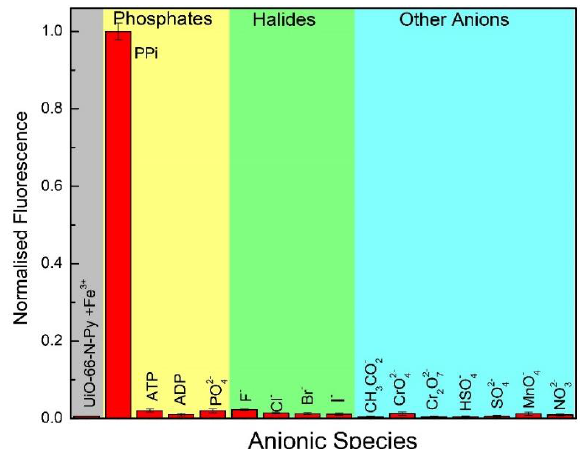
Figure 7. Change in the normalized fluorescence emission of UiO-66-N-Py + Fe 3+ in water upon addition of 200 µ L of different anionic species (10 −2 M).